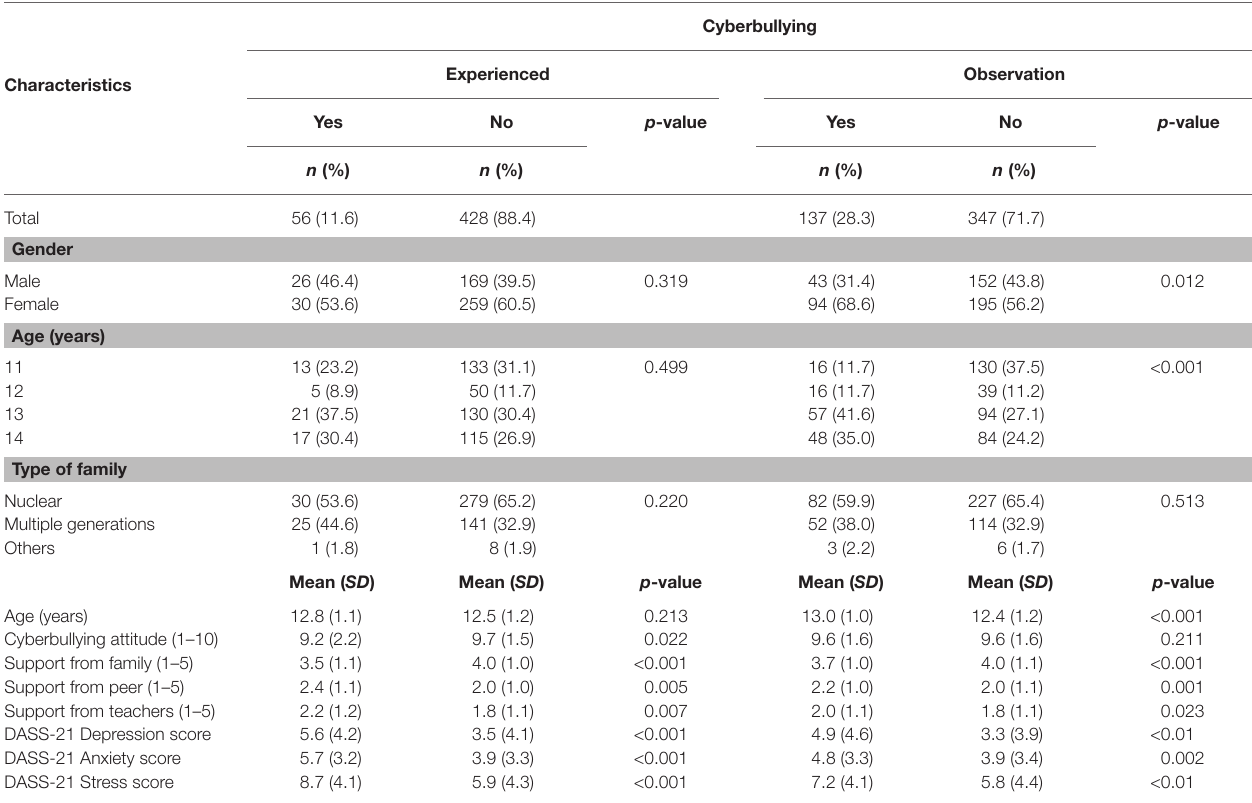
TABLE 1 | Cyberbullying experienced and observation according to sociodemographic levels of support and mental problems ( n = 484).